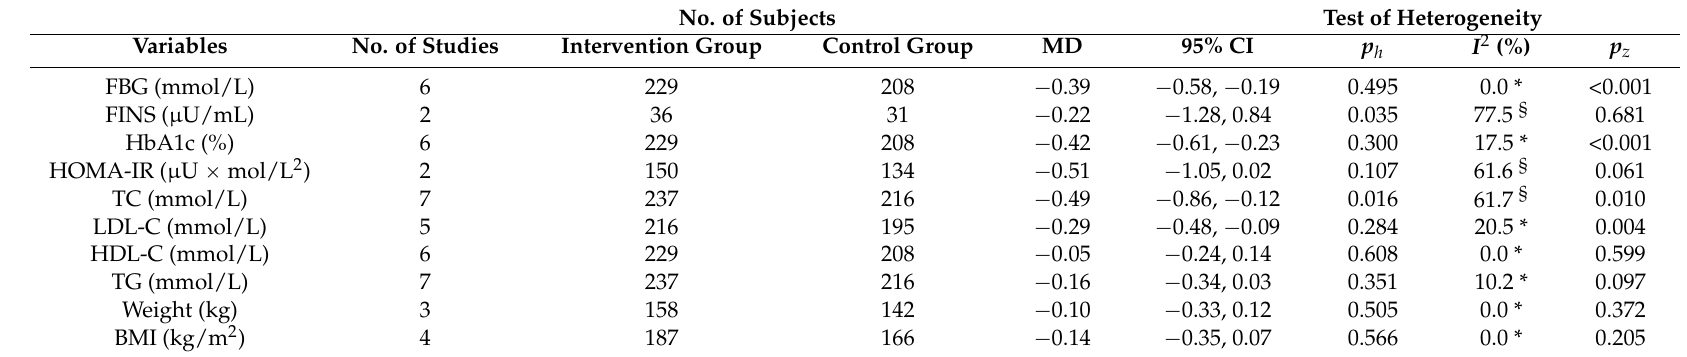
Table 3. Pooled effects of oats intake on metabolic parameters of type 2 diabetic